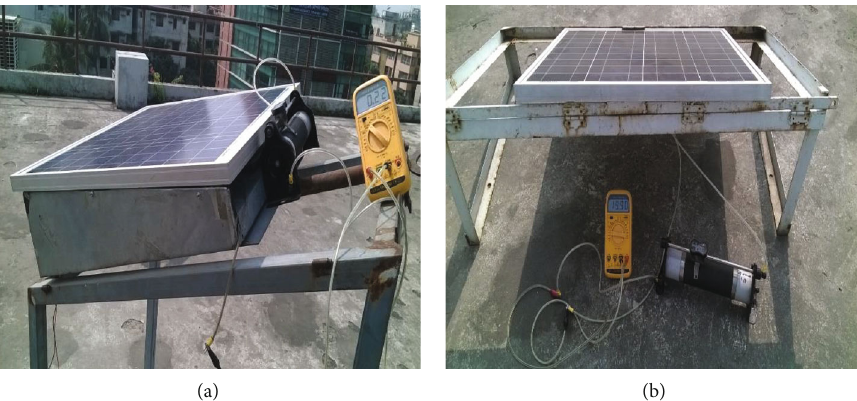
Figure 4: Digital multimeter is connected to measure the voltage and current. (a) The PVT system and (b) the normal